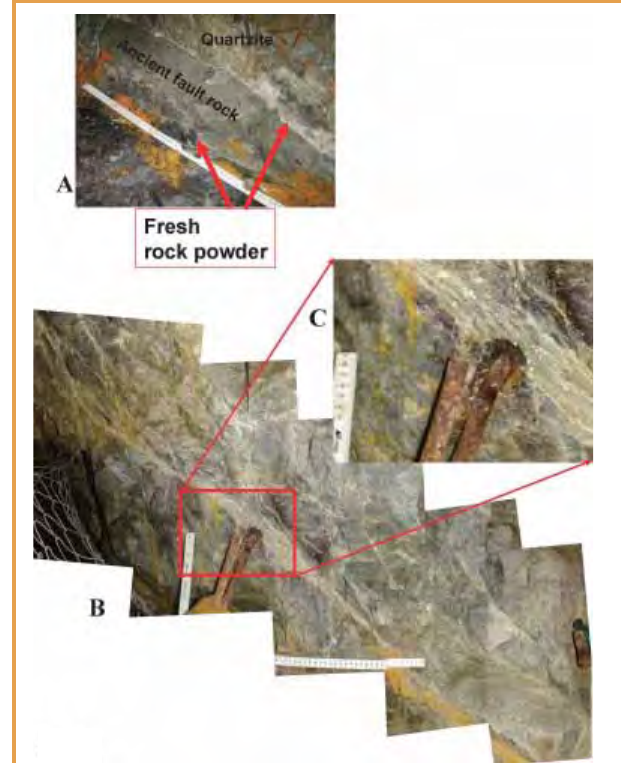
Figure 4. Details of rupture zone of earthquake of magnitude 2.2 of 12 December 2004. Rupture zone location is marked in Fig. 2B. [A] Close-up view of a reactivated segment. [B] A 41° segment with multiple wing-cracks, about fi ve zones of fresh powder and a dis- placed rock bolt. [C] Close-up view of displaced rock